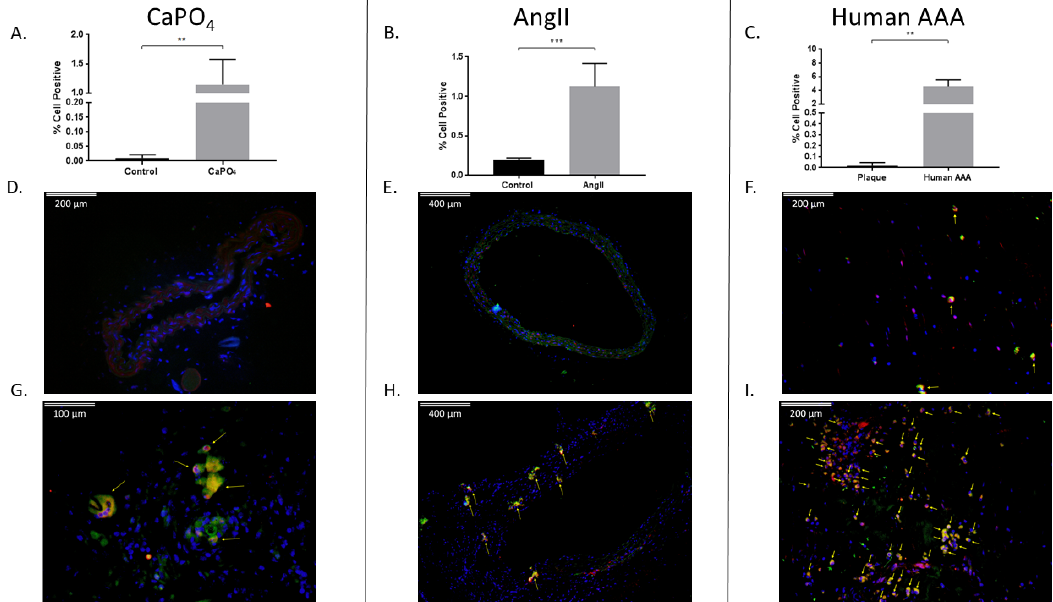
Figure 6 . Mouse and human aneurysms contain more TPMs than non-aneurysmal control tissues. Mouse CaPO 4 ( A ), mouse AngII ( B ), and human ( C ) aneurysms exhibit more TPMs (cells double-positive for expression of the myeloid marker, CD11b, and the osteoclast marker, TRAP) than respective controls. ( A – C ) show TPMs as a percentage of live cells in tissues from CaPO 4 mice ( n = 5) ( A ), AngII mice ( n = 6) and PBS-only controls ( n = 3) ( B ), human AAA ( n = 4) and human carotid plaques ( n = 3) ( C ). Tissues were enzymatically digested and processed to obtain single-cell suspensions for flow cytometric analysis, as described in the Methods section. ( D – I ) Immunofluorescence staining of frozen control and aneurysmal sections. Control sections ( D – F ), and aneurysmal sections ( G – I ) were stained for CD11b (red), TRAP (green), and DAPI (blue) as described in the Methods section. Yellow arrows indicate TPMs. 100 × magnification ( E , H ), 200 × magnification ( D , F , I ), 400 × magnification ( G ). Data are expressed as mean ± SEM. ** p < 0.01, *** p < 0.001. TPM,